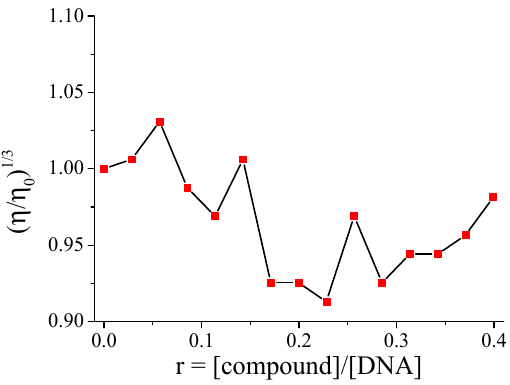
Figure 6. Relative viscosity ( η / η o ) 1/3 of CT DNA (0.1 mM) in buffer solution (150 mM NaCl and 15 mM trisodium citrate at pH 7.0) in the presence of NL004 at increasing amounts ( r = [NL004]/[DNA]).